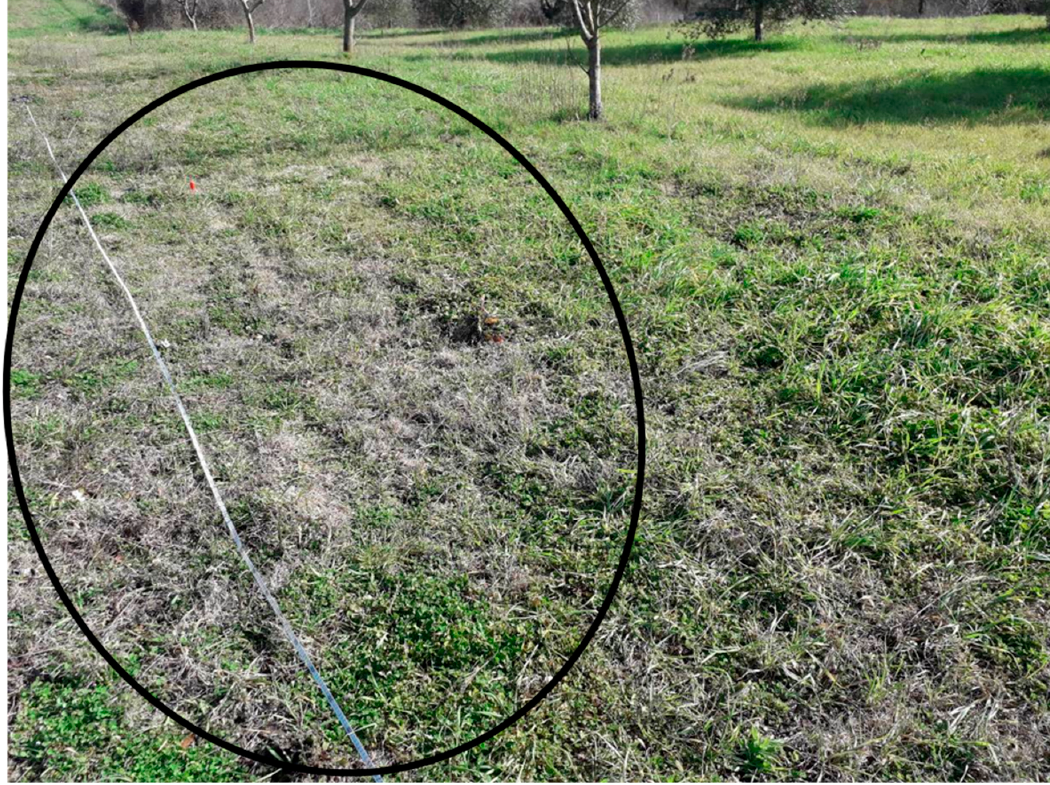
Figure 5. The visible parch marks with grass that is a paler green due to possible buried manmade